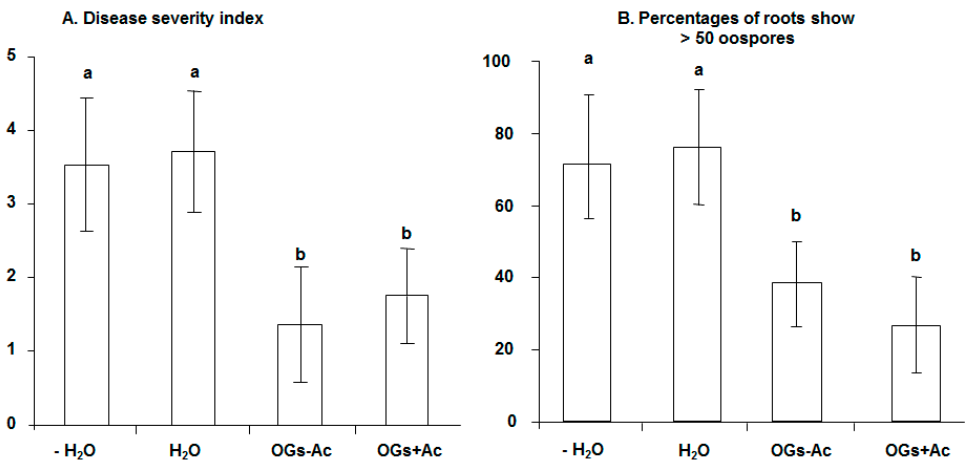
Figure 3. ( A ) Pea root rot disease severity index; ( B ) Percentage of roots showing >50% of oospores, at 10 days after inoculation with Aphanomyces euteiches at 10 5 zoospores/plant at 5-weeks-old. The upper two rachises of plants were injected with 20 µg/rachis (=40 µg/plant) of acetylated oligogalacturonides (OGs + Ac) or nonacetylated OGs (OGs − Ac) two weeks before inoculation. H 2 O; controls injected with water, − H 2 O; controls without water injection. The values shown are means with SD ( n = 5). Different lower-case letters indicate significant differences between treatments according to the Tukey test ( p ≤ 0.05).